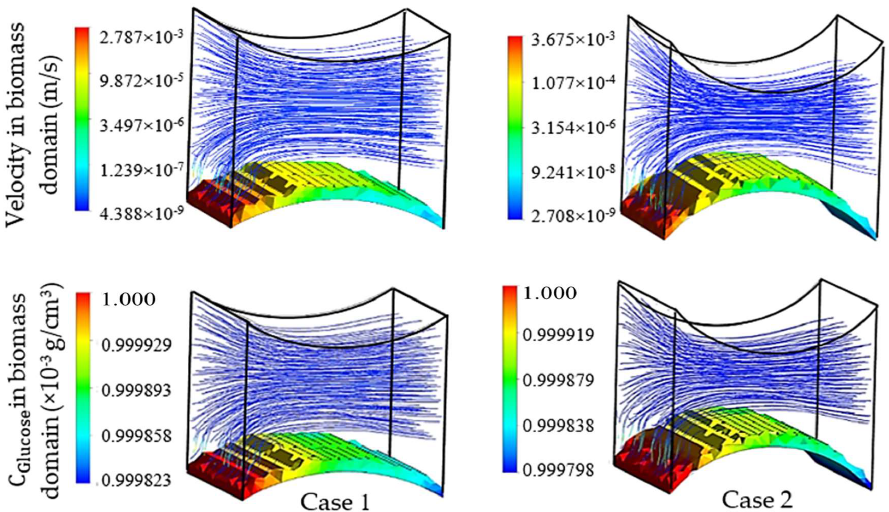
Figure 7. Physical effect of fiber 1 on the cell culture with initial cell density = 5 × 10 7 cells/cm 3 in the biomass phase, inlet velocity = 3 mm/s and inlet glucose concentration = 1 × 10 −3 g/cm 3 , 𝐷 (cid:2869)(cid:3030)(cid:3028)(cid:3046)(cid:3032)(cid:2869) = 520 μm , 𝐷 (cid:2870)(cid:3030)(cid:3028)(cid:3046)(cid:3032) = 0 μm and 𝐷 (cid:2869)(cid:3030)(cid:3028)(cid:3046)(cid:3032)(cid:2870) = 250 μm , 𝐷 (cid:2870)(cid:3030)(cid:3028)(cid:3046)(cid:3032) = 0 μm